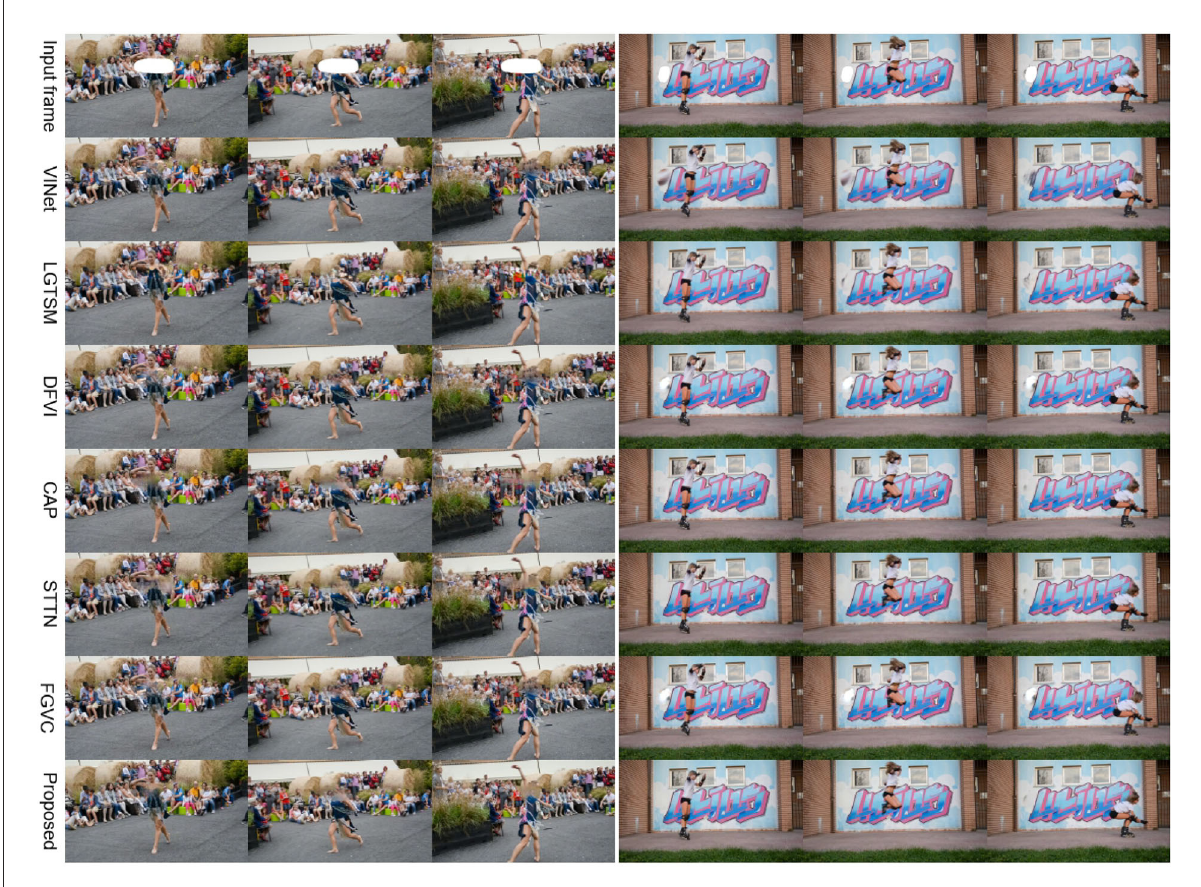
FIGURE3 Qualitative comparison with other methods for stationary